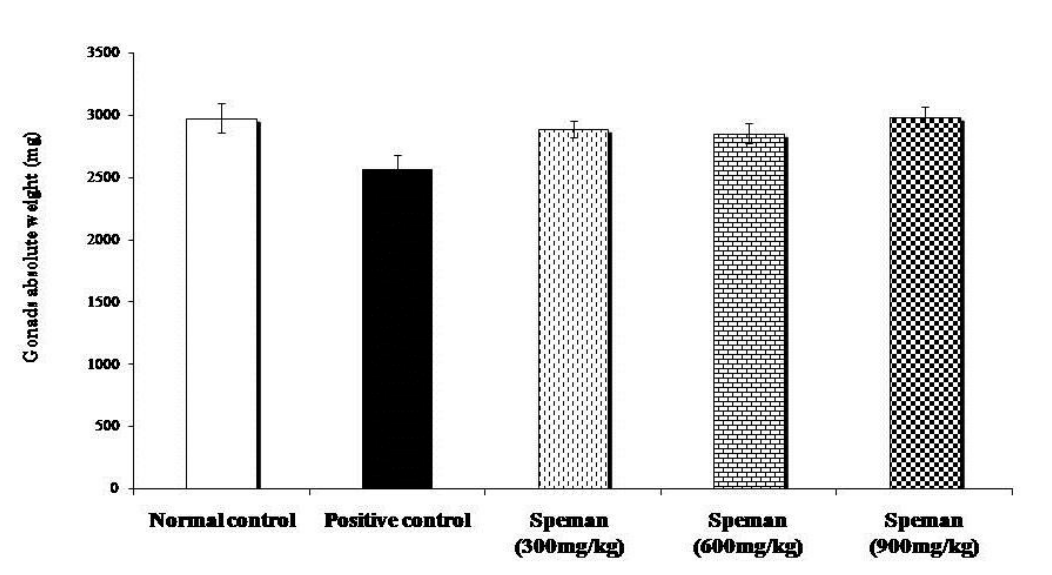
Figure 5: Effect of Speman ® on the absolute weight of gonads in an experimental model of CP-induced oligospermia in